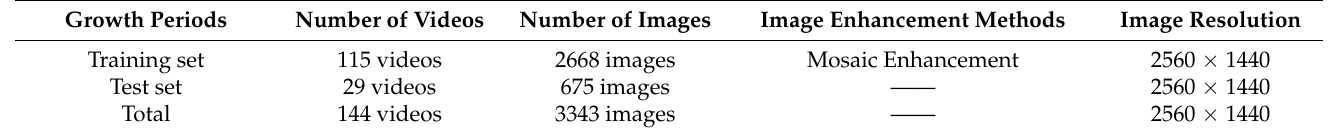
Table 1. Cow mounting datasets.